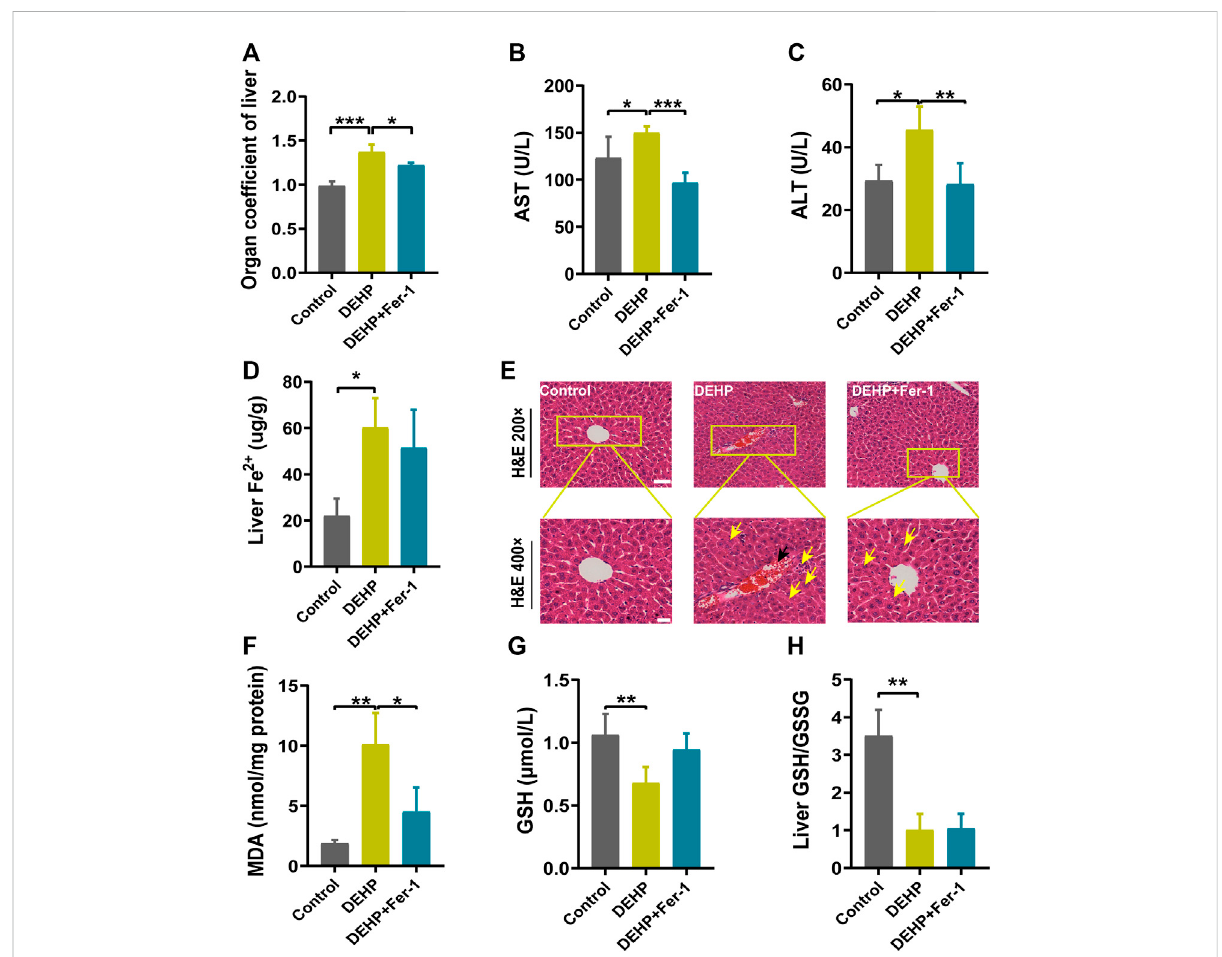
FIGURE 4 Fer-1alleviatedDEHP-inducedliverinjuryinpregnantmice. (A) Liverweight/bodyratio. (B) SerumlevelsofAST. (C) SerumlevelsofALT. (D) The level of Fe 2+ in the liver. (E) Liver sections were stained with H&E in the normal control, DEHP, and DEHP + Fer-1 group. H&E magni fi cation, fi rst row, 200× (scale bar = 100 μ m); second row, 400× (scale bar = 50 μ m). The black arrow indicates hyperemia in the central vein. The yellow arrow indicates swollen hepatocytes, focal necrosis, and in fl ammatory cell in fi ltration. DEHP + Fer-1-treated liver sections showed that the severe signs of liver damage induced by DEHP were signi fi cantly attenuated. (F) MDA content in the livers of mice. (G) GSH content in the livers of mice. (H) Liver GSH/GSSG ratio. Data are presented as the mean ± SD. AST, aspartate aminotransferase; ALT, alanineaminotransferase; H&E, hematoxylin and eosin; MDA, malondialdehyde; GSH, glutathione. * p < 0.05, ** p < 0.01, *** p <